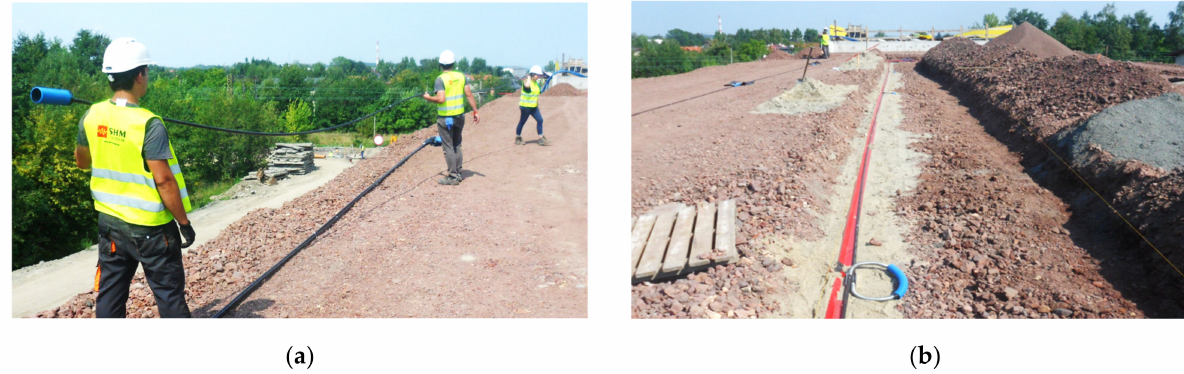
Figure 22. ( a ) The view of 3DSensor just before installation in the embankment; ( b ) the view of ready measurement line with 3DSensor and inclinometer casing.